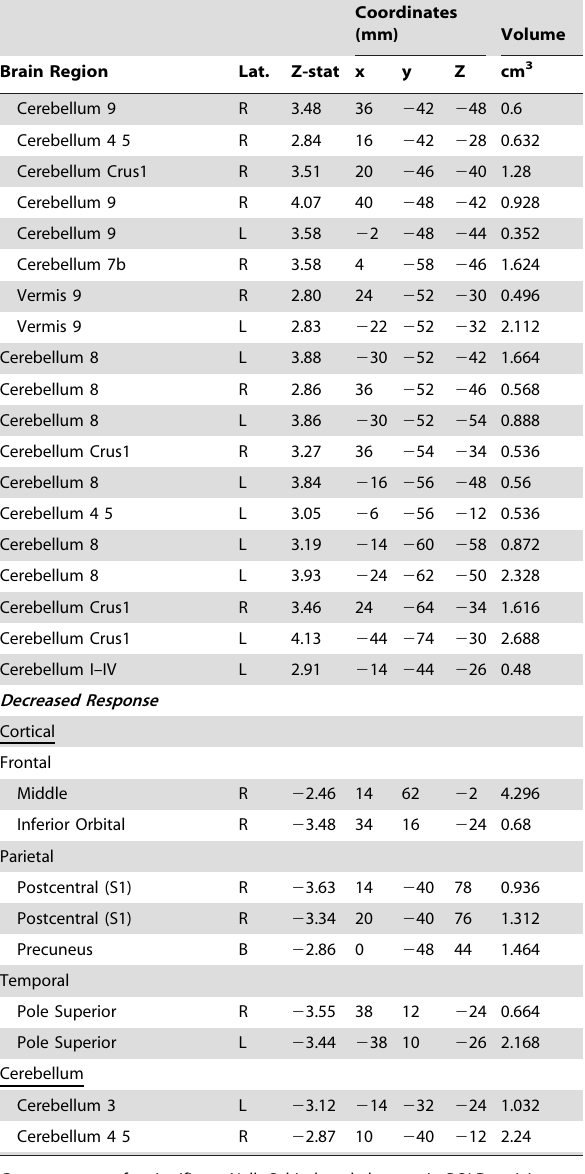
Group averages for significant Nalb-Sal-induced changes in BOLD activity. General brain regions, given in the left column, may contain several significantly activated/deactivated regions, each listed with its MNI-152 coordinates. See Fig. 3 (‘‘Nalb-Sal’’) for maps depicting the data in this table. ‘‘Lat.’’ indicates the brain laterality (i.e., R=right side, L=left side). Z-stat is given for each region. Coordinates: x=mm right (positive values) or left (negative values); y=mm anterior (positive values) or posterior (negative values); and z=mm superior (positive values) or inferior (negative values). Volume is the volume of the region showing significant BOLD activation or deactivation.